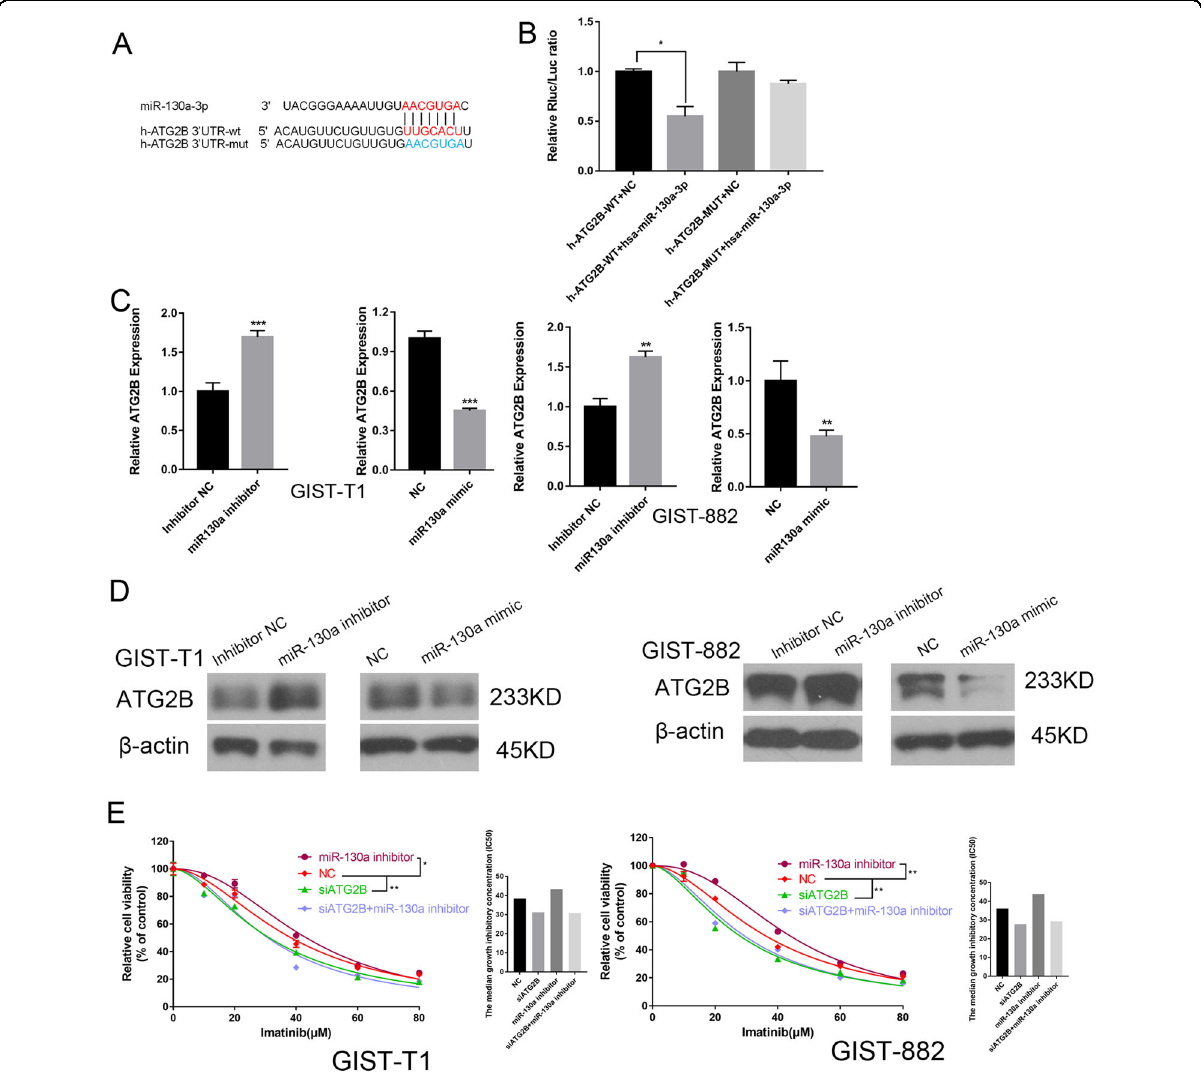
Fig. 5 miR-130a directly targets ATG2B . A The TargetScan predicted the binding site for miR-130a in the 3 ′ -UTR of ATG2B . B Dual-Luciferase reporter assays analyzing the putative targets of miR-130a. * P < 0.05 vs. h- ATG2B -WT + NC. C , D The results of western blotting and qRT-PCR showing that miR-130a regulates ATG2B in GIST cells. ** P < 0.01; *** P < 0.001 vs. the NC or inhibitor NC. E CCK-8 assays were used to measure the changes in cell viability after different transfection of GIST cells. * P < 0.05; ** P < 0.01 vs.